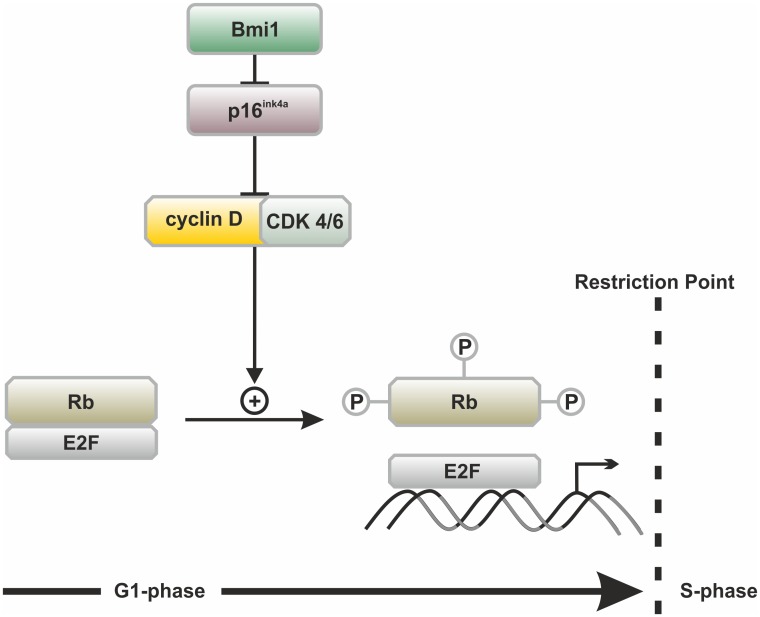
The mechanism of cell cycle regulation via the Bmi1/p16ink4a pathway.Bmi1 represses p16ink4a, which in turn inhibits cyclin-dependent kinases 4/6 (CDK4/6) from binding to cyclin D. CDK4/6-cyclin D complexes are required for the phosphorylation of the retinoblastoma (Rb) family of proteins. In the absence of CDK4/6-cyclin D complexes, Rb remain in their inactive hypophosphorylated form. After phosphorylation, Rb release the elongation factor 2 (E2F) group of transcription factors. E2F activate the transcription of various genes that are required for progression from the G1-phase of the cell cycle, through the restriction point and into the S-phase. After passing the restriction point, the cell becomes committed to the cell cycle even in the absence of external proliferation stimuli. Figure adapted from [48].